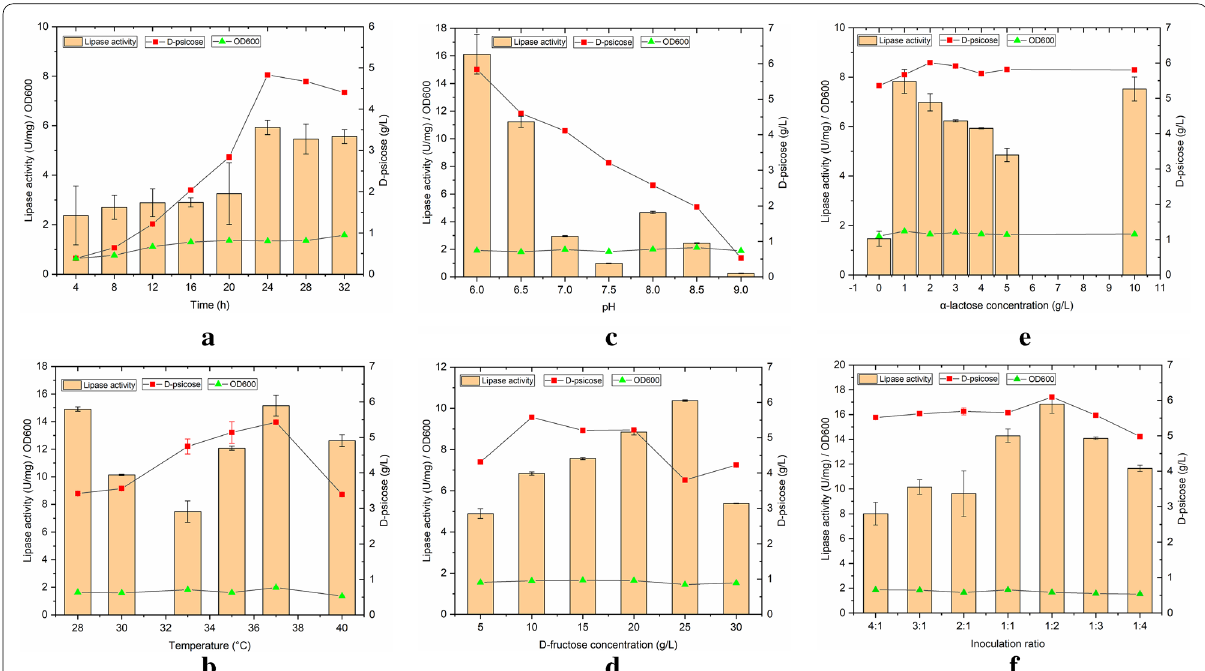
Fig. 2 Effects of co-culture conditions on the co-production of D-psicose and lipase. a fermentation time (2 g/L α -lactose, 10 g/L D-fructose, initial pH 6.0, 37 °C, 32 h, and inoculation ratio of recombinant B. subtilis and E. coli initial pH 6.0, 24 h, and inoculation ratio of recombinant B. subtilis and E.